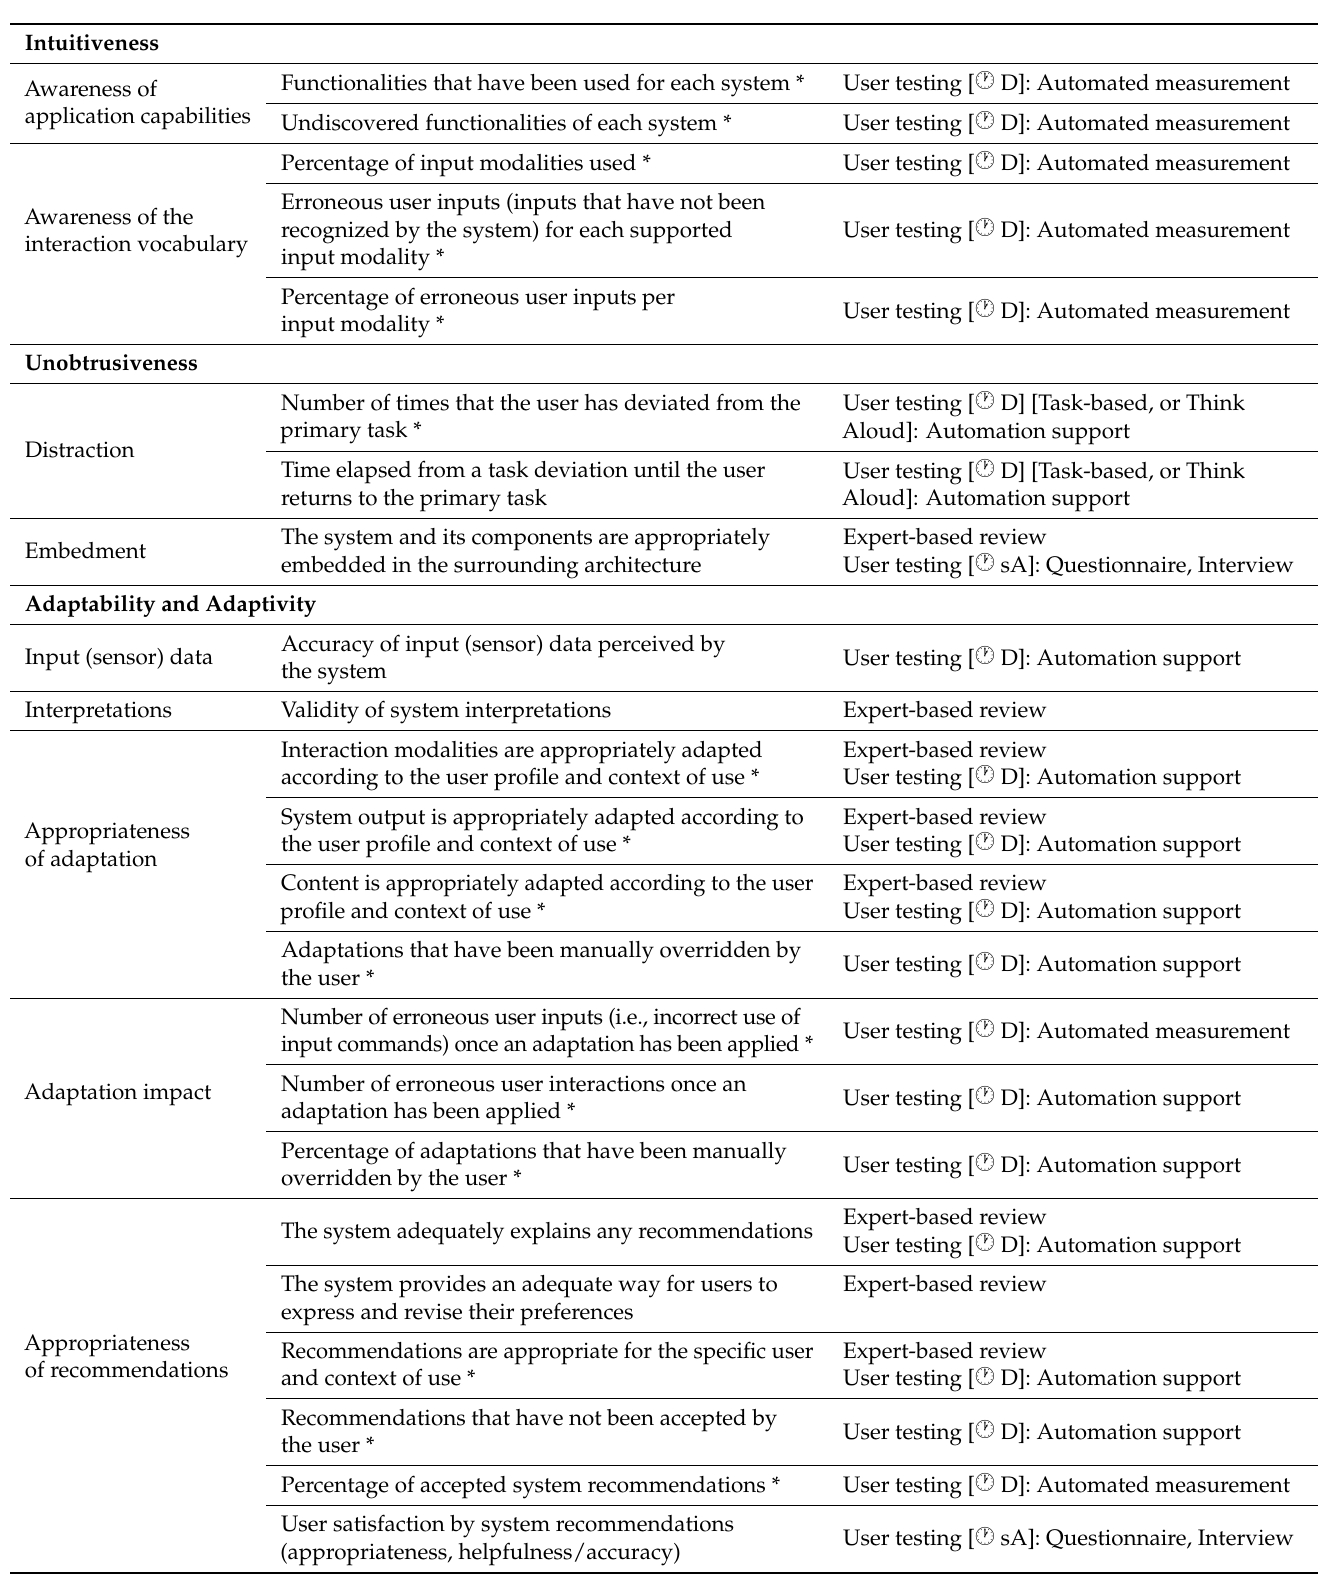
Table 1. The UXIE framework: concepts, attributes, metrics and methods. Asterisk (*) denotes metrics that are novel in the UXIE framework.